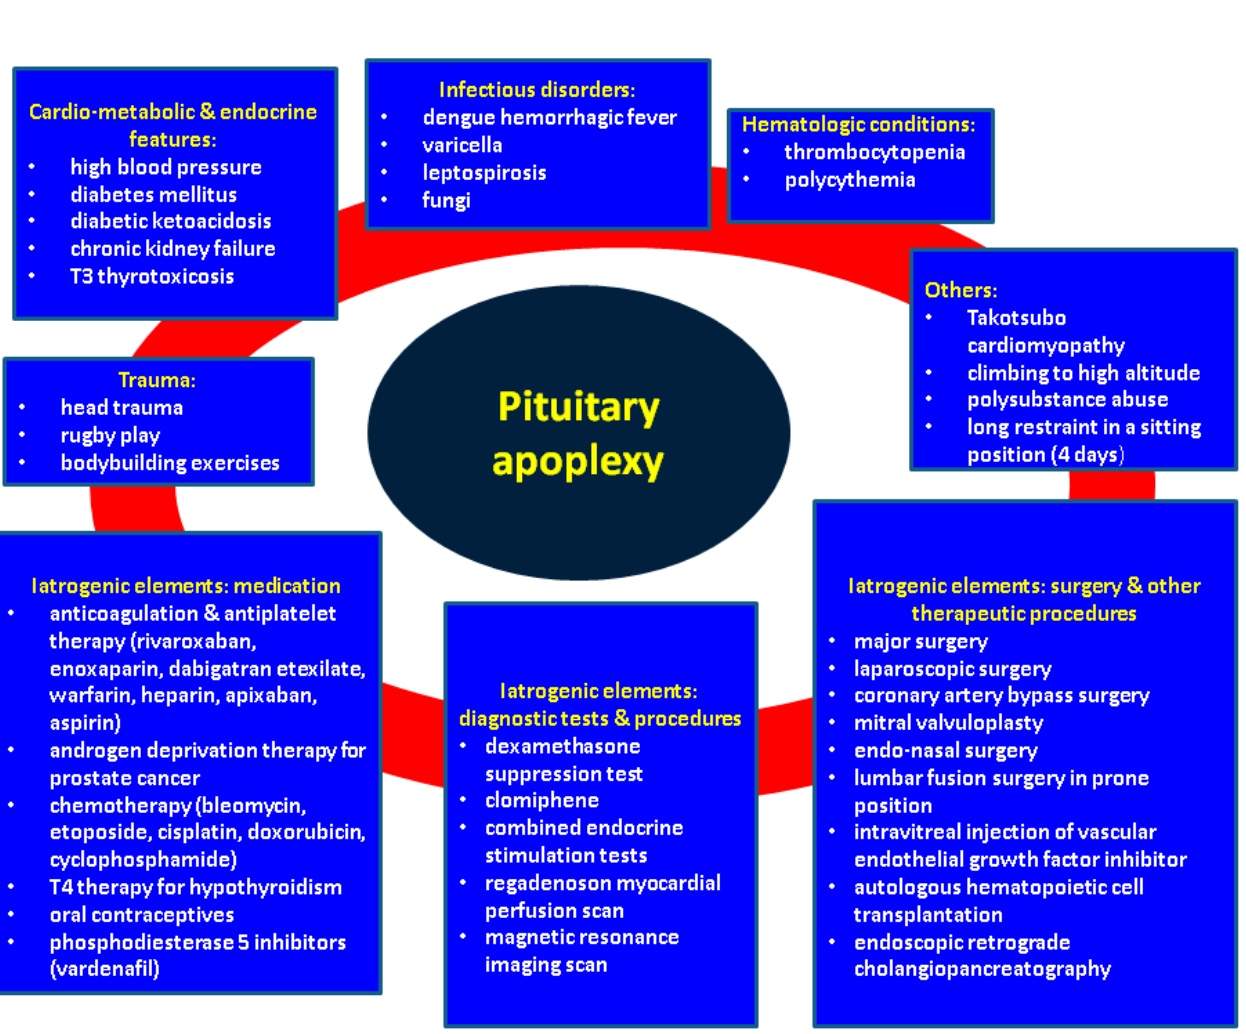
Figure 2. Qualitative analysis of potential contributors to spontaneous PA in PitNETs that are not previously treated (outside pregnancy and coronavirus infections). Abbreviations: T3 = triiodothyronine; T4 = thyroxine.